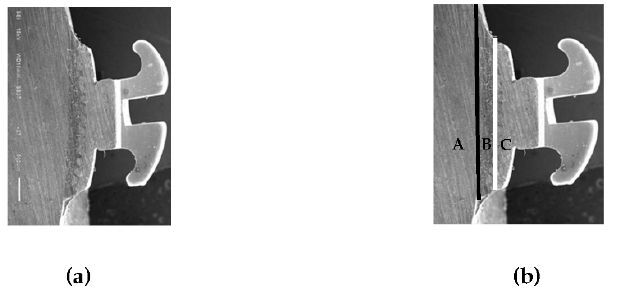
Figure 2. ( a ) Cross-sectional SEM image of the teeth with metallic bracket (original magnification ×27, bar represents 500 μm); ( b ) A, enamel layer; B, adhesive layer; C, bracket base layer; black line, enamel–adhesive interface; white line, bracket base–adhesive interface.